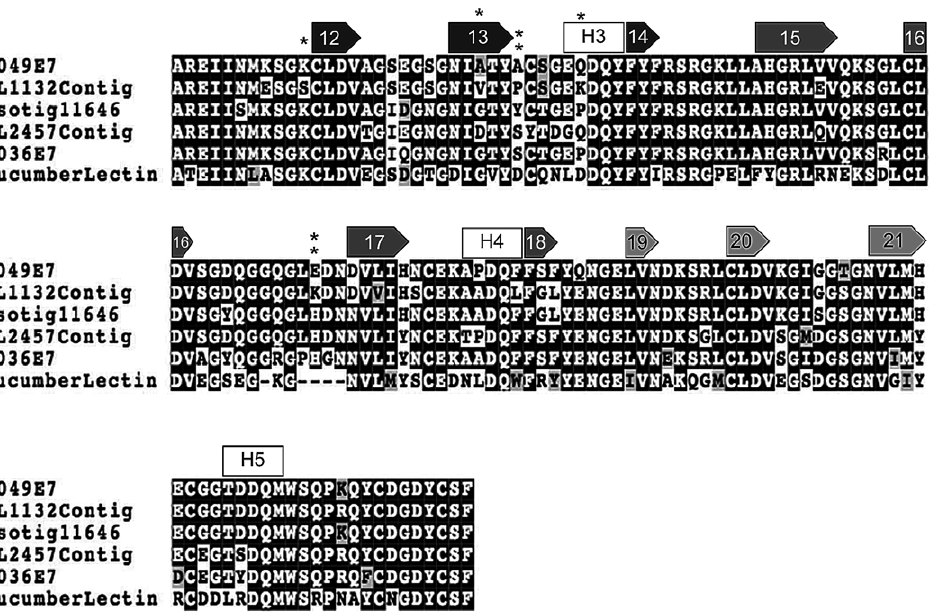
Figure 3. Boxshade alignment of five coral CEL-III lectins and sea cucumber CEL-III. Dark grey boxes are b -strands of subdomain 1 c , grey boxes are those of subdomain 2 a , and bright grey boxes are those of subdomain 2 c . White boxes show 3 10 helices. The numbers of boxes are in accordance with Uchida et al. [34].